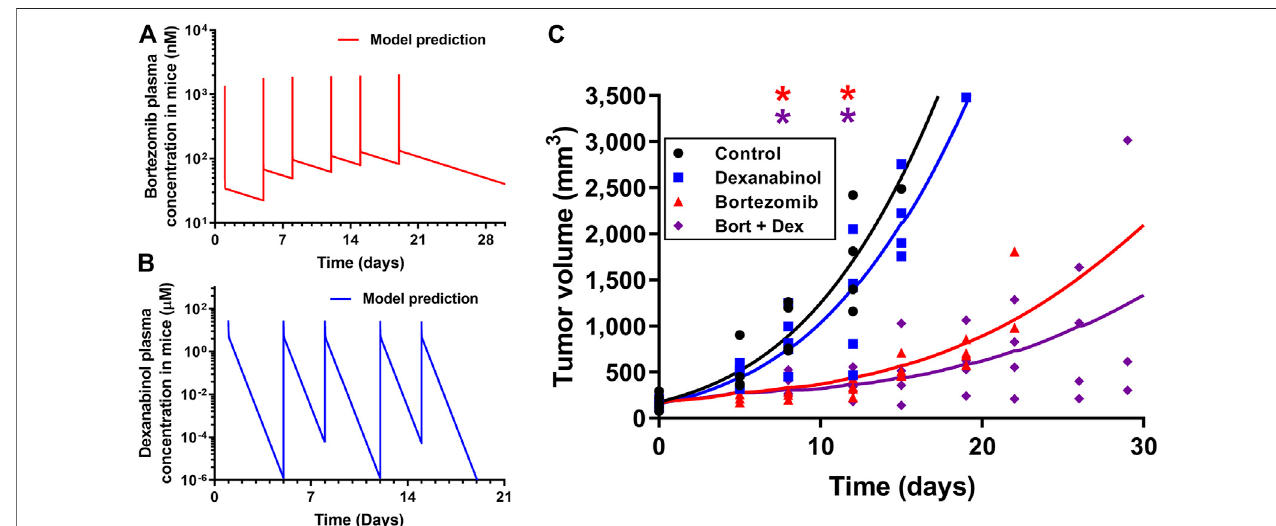
FIGURE 7 | Pharmacokinetics and pharmacodynamics of dexanabinol and bortezomib in a MM1.S multiple myeloma mouse model. Model predicted mouse plasmaconcentrationsof (A) 1 mg/kgofbortezomibadministeredonDays1,5,8,12,15,and19and (B) 10 mg/kgofdexanabinoladministeredonDays1,5,8,12,and 15. (C) Pharmacodynamics of bortezomib and dexanabinol on MM1.S tumor volume in SCID mice. Tumors were grown to approximately 100 mm 3 prior to drug administration. Mice ( n (cid:1) 20) were divided into four treatment groups: treatment naïve (black), dexanabinol (blue), bortezomib (red), and their combination (purple). Bortezomib and dexanabinol were administered IP twice weekly (1 and 10 mg/kg). Tumor volume measurements and pharmacodynamic model fi tted pro fi les are displayedassolidmarkersanddashedlines.Asterisksindicatestatisticalsigni fi cancefromcontrol(corrected p value < 0.5),whichwereobtainedviamultiplet-testswith Holm-Sidak Bonferroni correction (GraphPad Prism